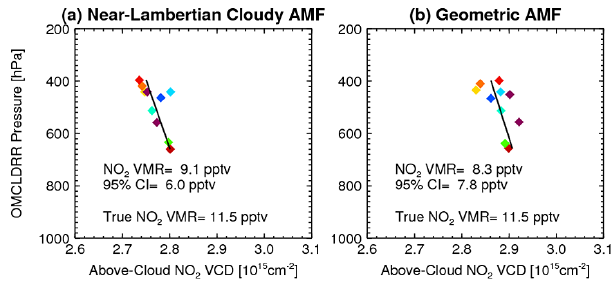
Figure 4. NO 2 VMRs derived from simulated OMI cloud OCPs and above-cloud NO 2 VCDs using (a) geometric AMFs, and (b) near- Lambertian cloudy